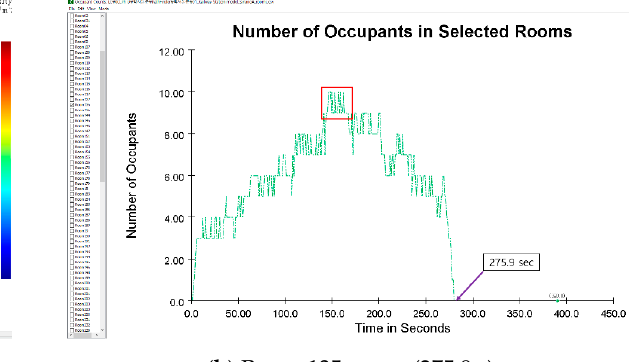
Figure 8. Results of Scenario A.